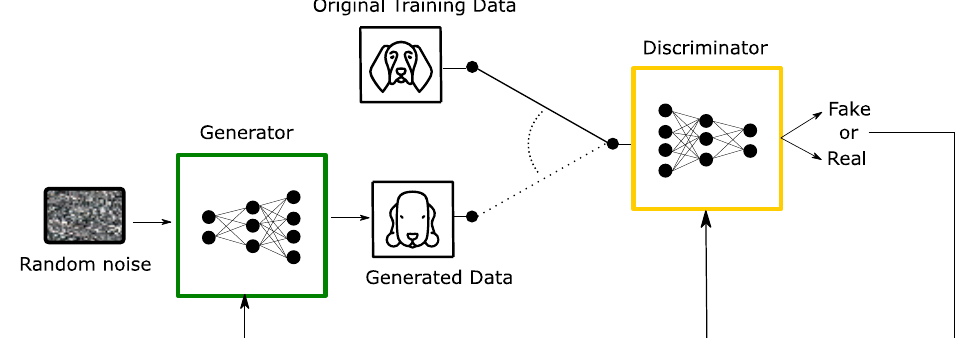
Figure 5. Generative Adversarial Network Architecture.